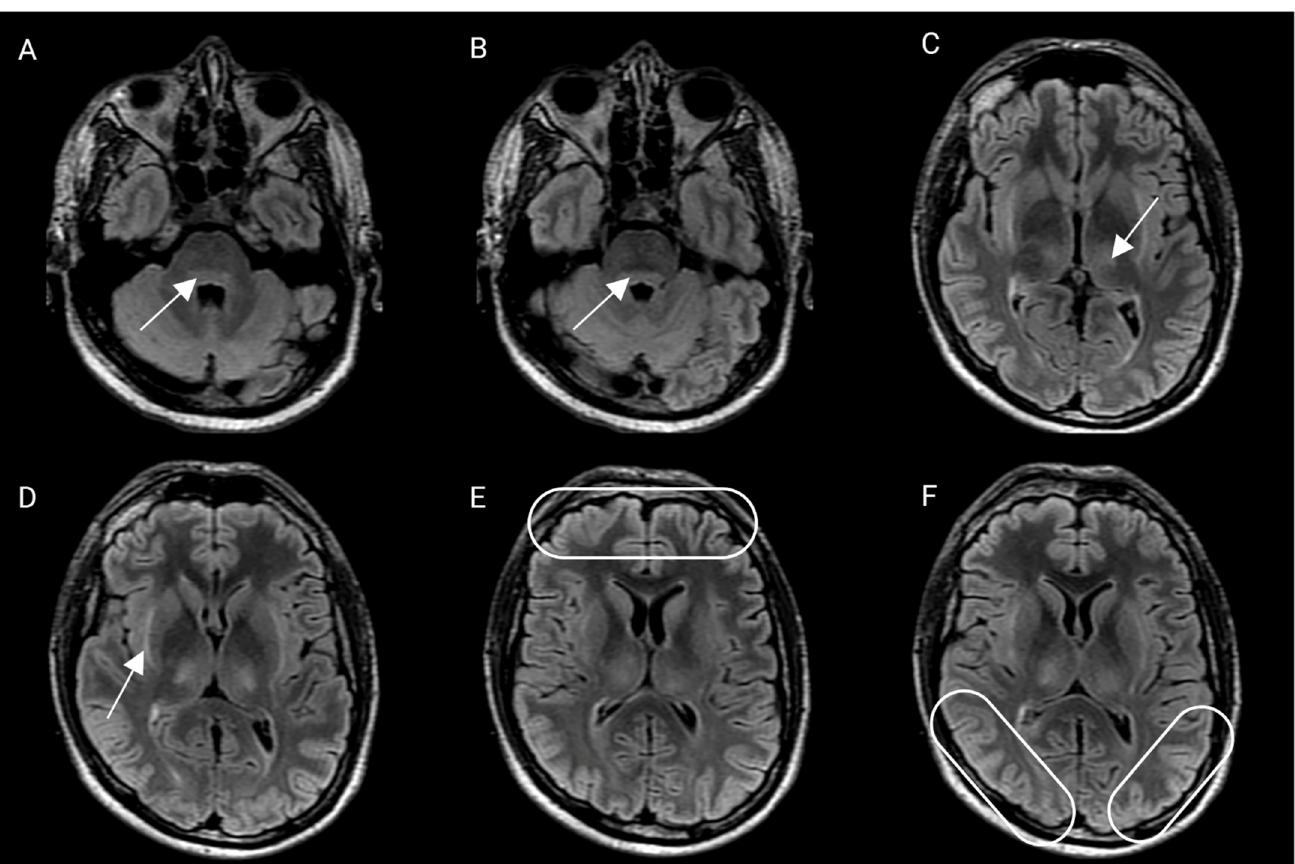
Figure 2. Brain magnetic resonance imaging, axial fluid-attenuated recovery sequence (FLAIR). Arrows and ovals show the areas described in each section. ( A , B ) There is a hyperintensity that shows a compromise of the dorsal pons at the level of the fourth ventricle, involving the nucleus of the VI and VII cranial nerves bilaterally. ( C ) There is a compromise of the thalamus at its ventromedial aspect, bilaterally. ( D ) Compromise of the subinsular external capsules. ( E , F ) There is evident cortical edema, most probably of cytotoxic origin.